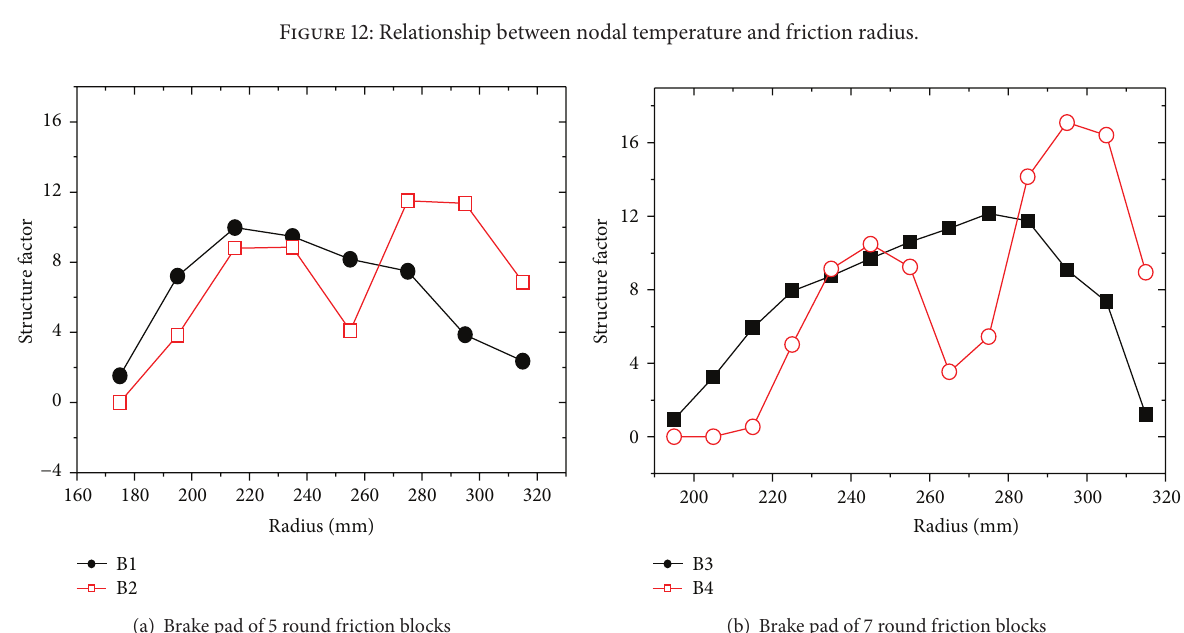
Figure 13: Relationship between structure factor and friction